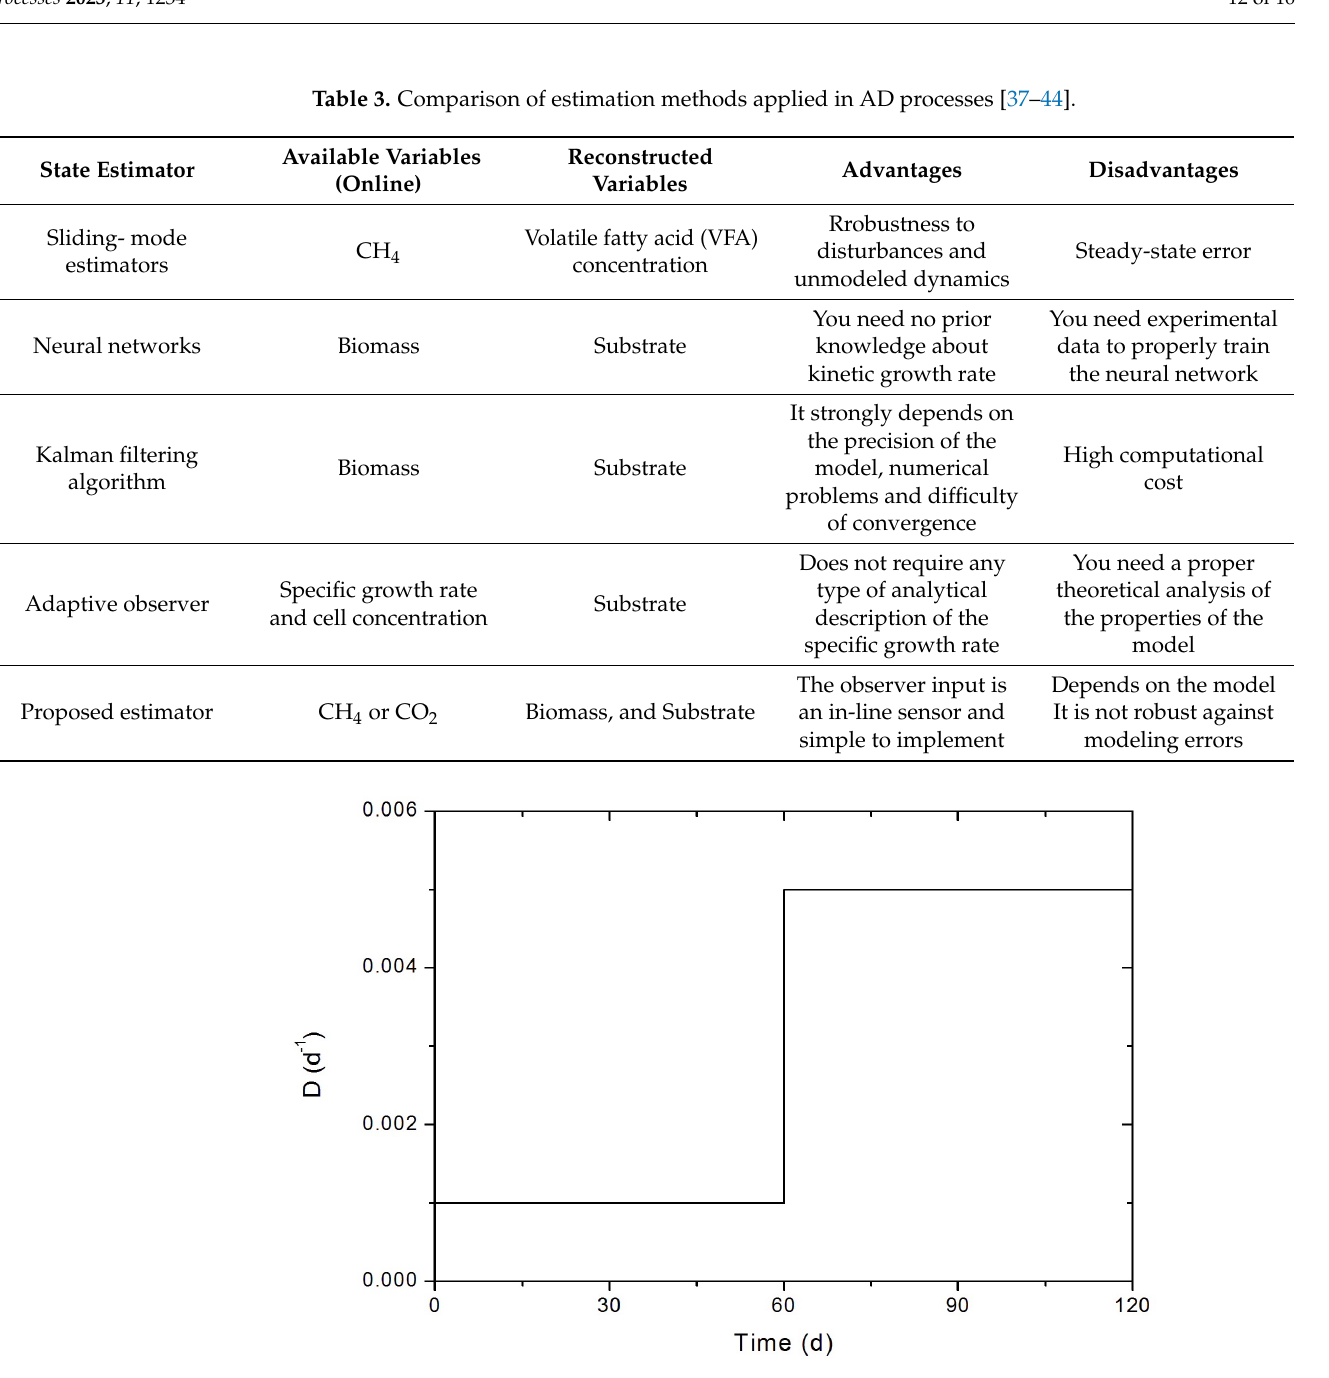
Figure 7. Parametric change on the proposed parameter